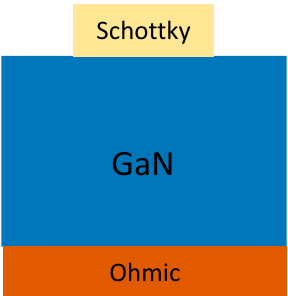
Figure 6. Sandwich structure of alpha particle detectors.